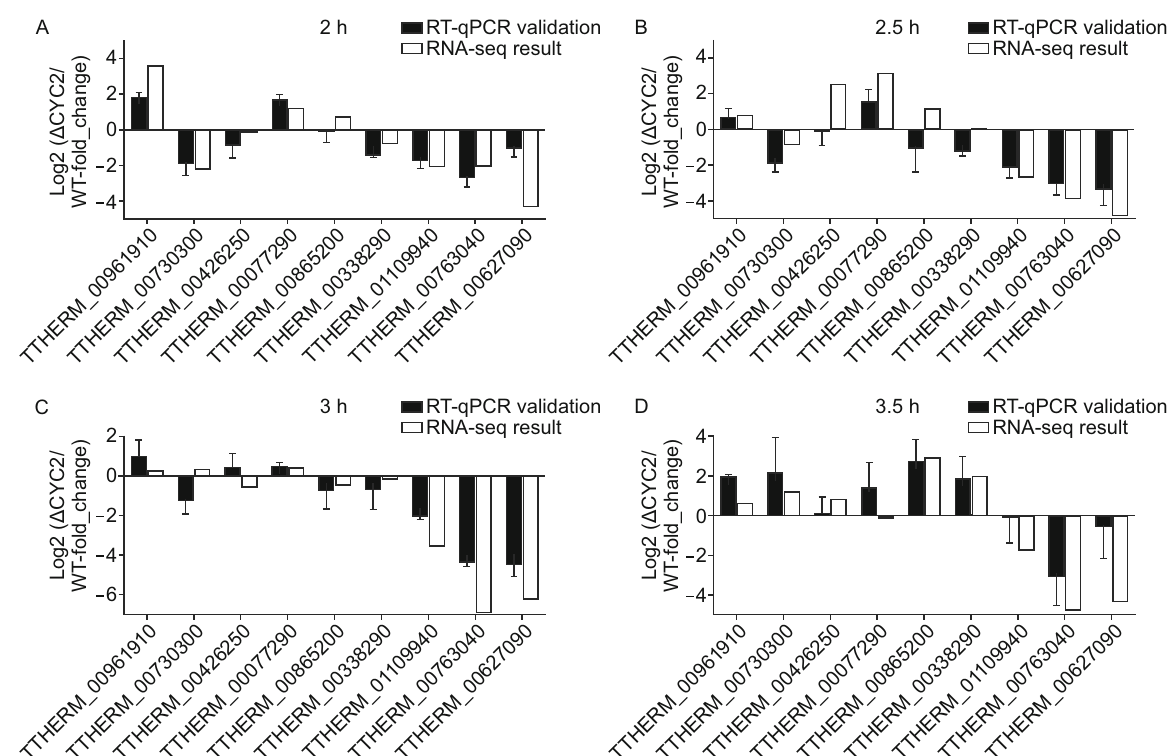
Figure 6. RT-qPCR veri fi cation of the RNA-Seq results. The 8 randomly selected genes (TTHERM_00961910; TTHERM_00730300; TTHERM_00426250; TTHERM_00077290; TTHERM_00865200; TTHERM_00338290; TTHERM_01109940; TTHERM_00763040) plus CYC2 TTHERM_00079530) and SPO11 (TTHERM_00627090) were performed with RT-qPCR.